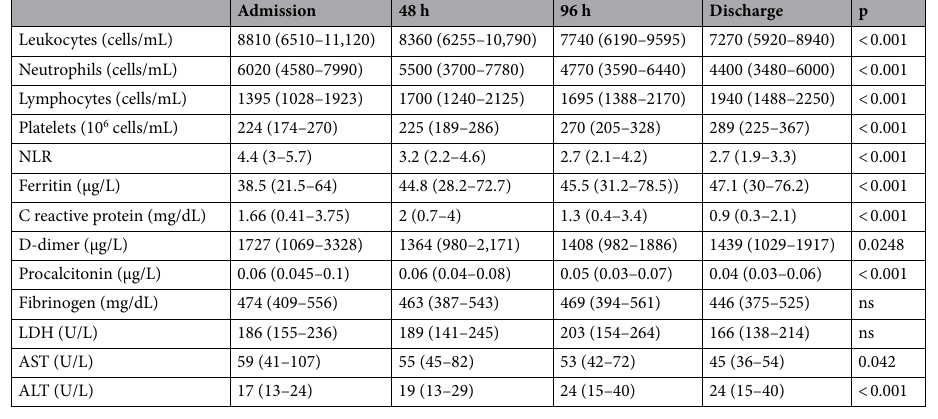
Table 2. Values (median and interquartile range) of inflammatory biomarkers and hemocytometry variables at different study timepoints. NLR neutrophils to lymphocytes ratio, LDH lactate dehydrogenase, AST aspartate aminotransferase, ALT alanine